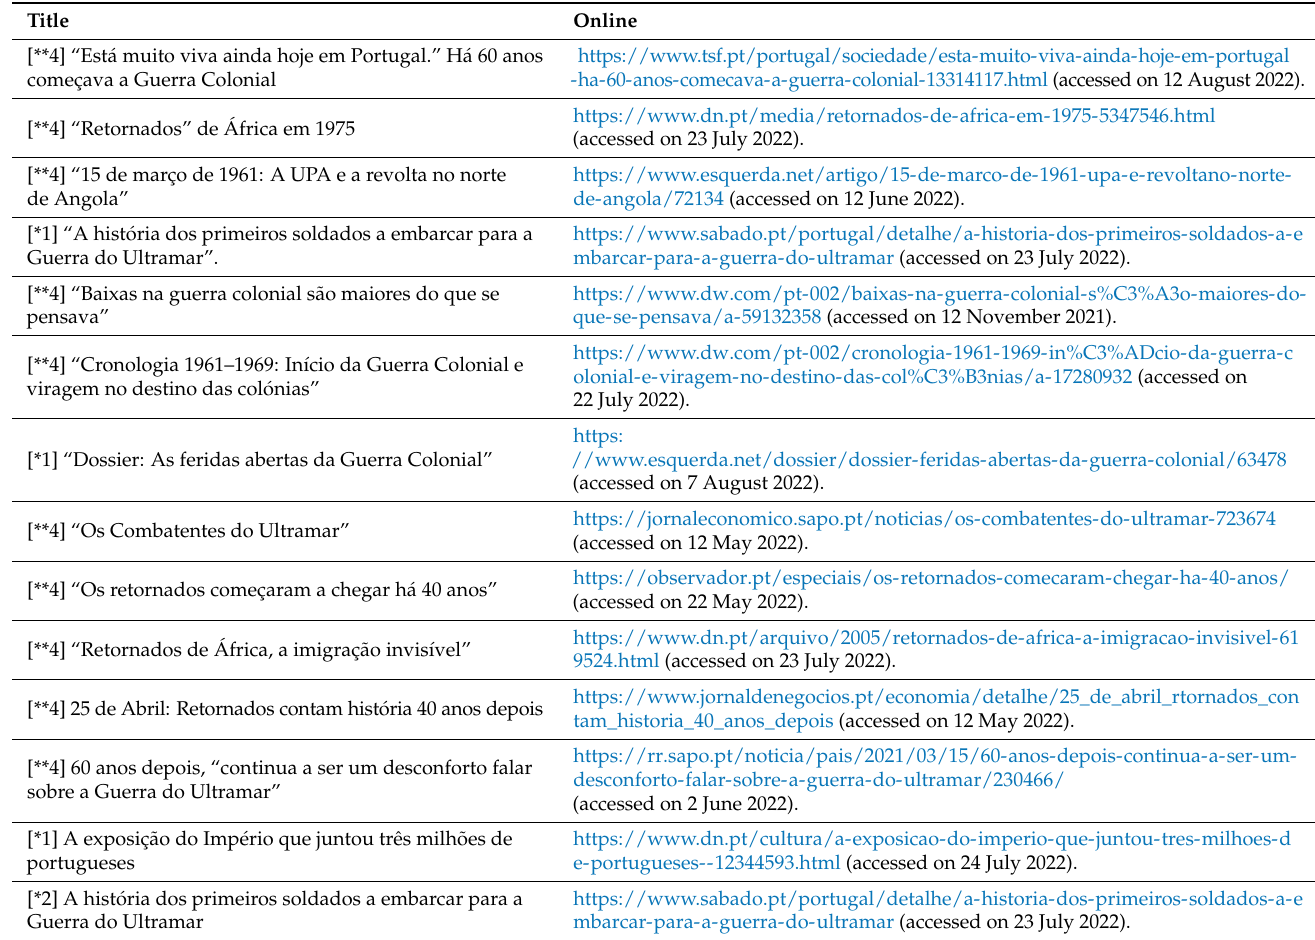
Table A1. Records (33) identified during the research and application of inclusion/exclusion